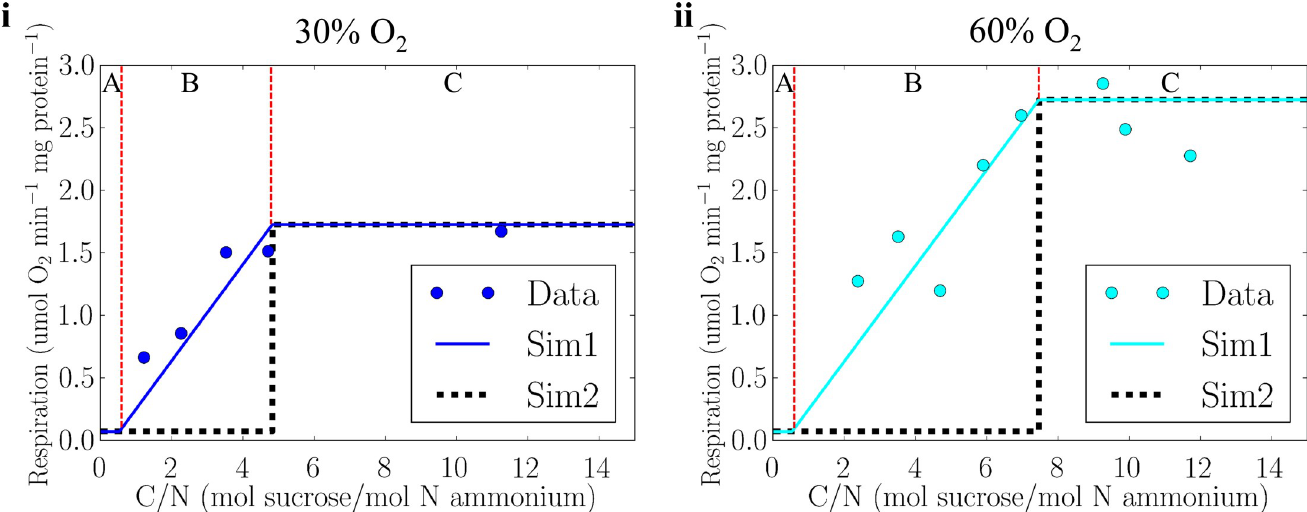
Fig 7. Respiration per protein as a function of C/N. Data (points) are shown as well as results of two simulation models. In one simulation (Sim1) energetically excess respiration can occur both during nitrogen fixation and during nitrogen limited growth on ammonium. In the second model (Sim2) excess respiration is allowed only during nitrogen fixation. Sim1 and Sim2 produce same amount of biomass. (i) 30% O 2 and (ii) 60% O 2 . Solids lines and points are same as Fig 3B. The dilution rate is constant of 0.15 h -1 , and red dashed lines show borders between different regimes (A: Carbohydrate limited, B: Ammonium limited, C: Nitrogen fixing as defined in Fig 5). Here 100% O 2 equals 225 μ M thus approximately O 2 saturation under normal air composition at 30˚C.